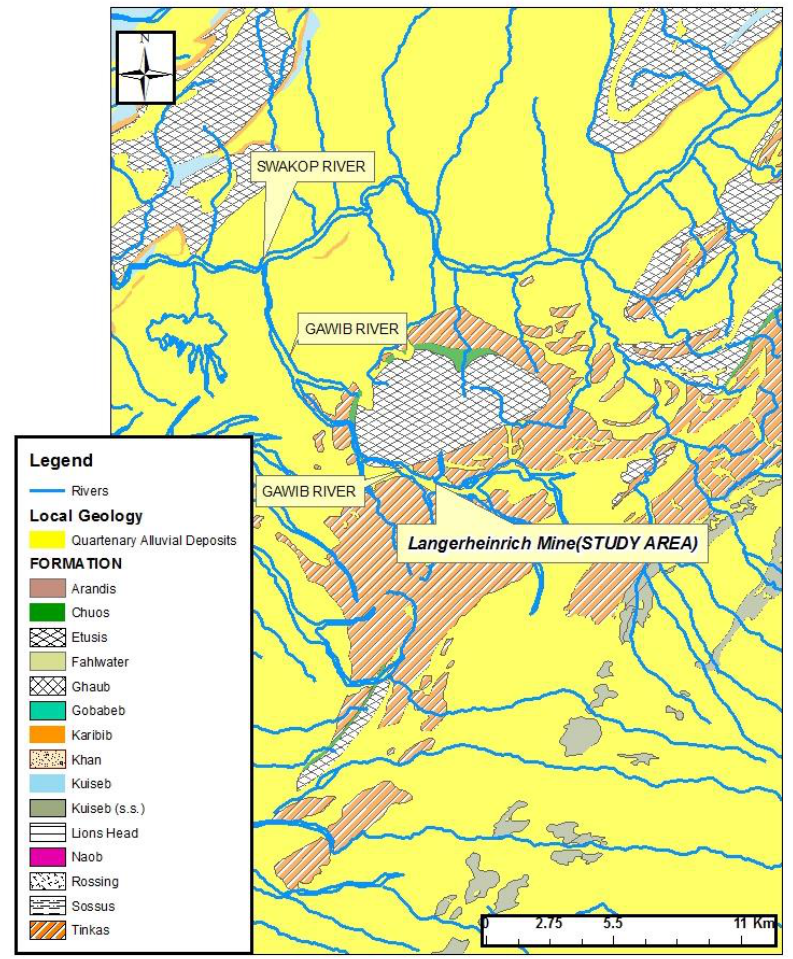
Figure 4. The local geology in the Langerheinrich Uranium Mine area.